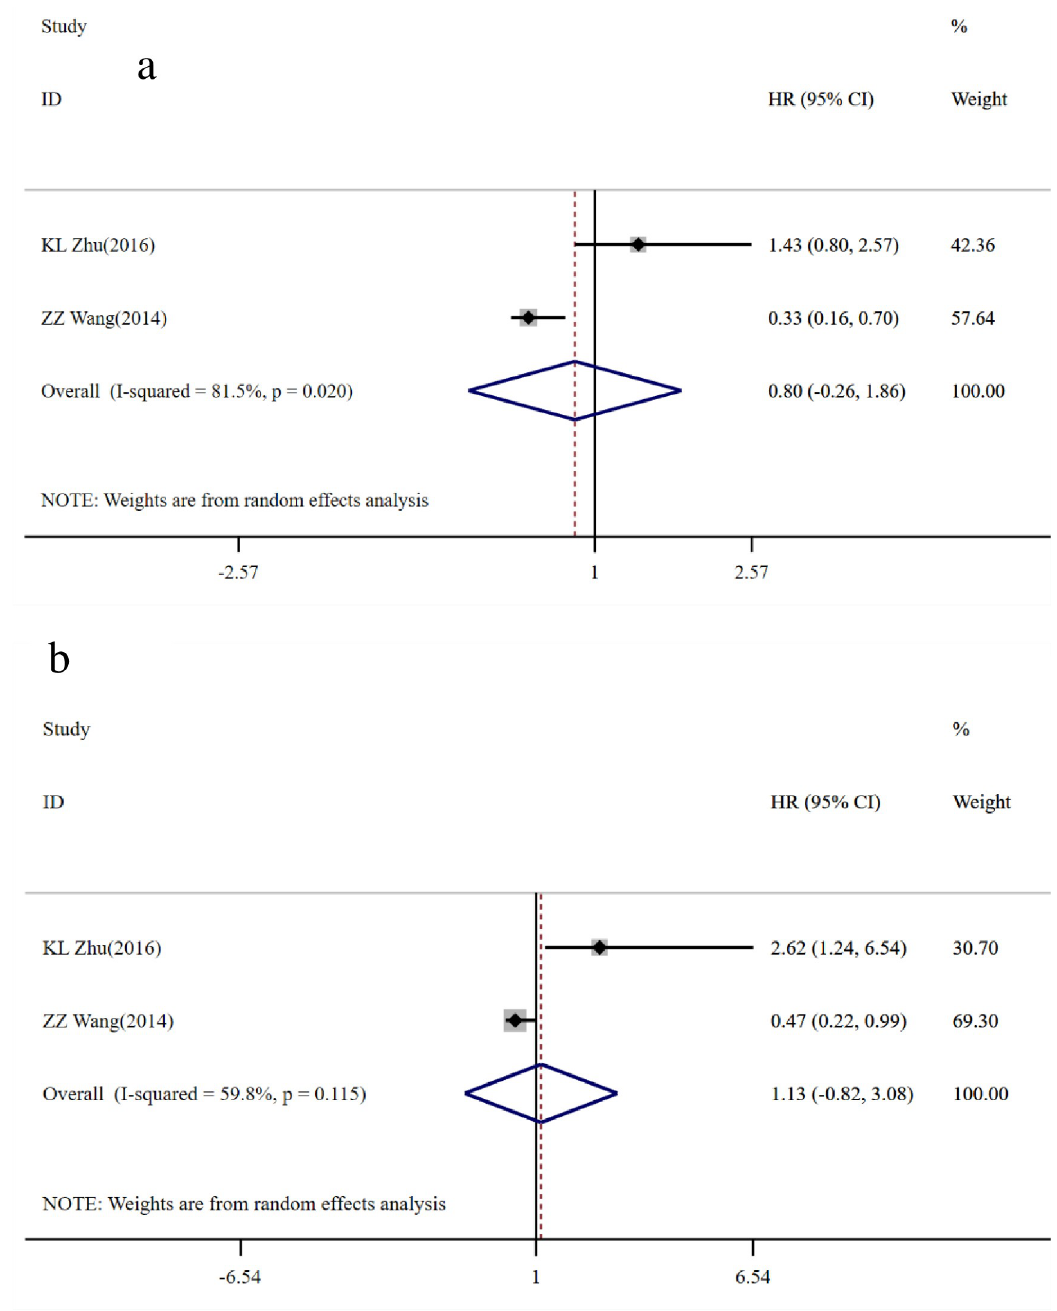
Fig 5. Forest map of GOLPH3 expression and disease-free survival (DFS). a: univariate analysis; b: multivariate analysis. The horizontal line represents the range in which the truth value of the study exists. The dots on the horizontal line represent the effect size of a single study, and the size of the dots represents the weight. Diamonds represent the result of the